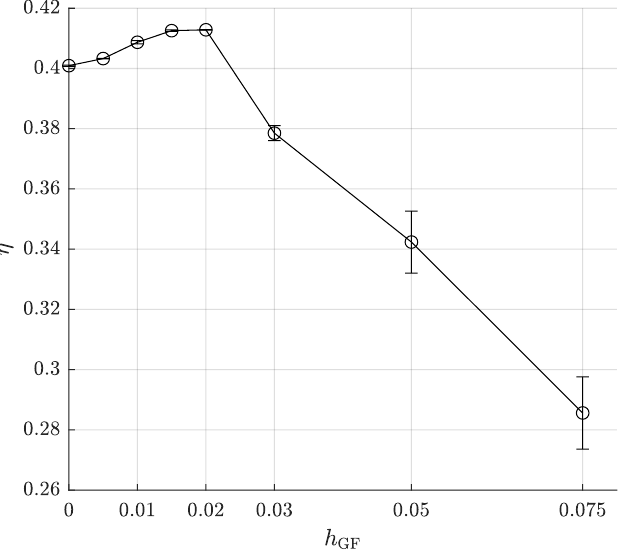
Figure 6. Effect of Gurney flaps on the performance of an OFT operating at f ∗ = 0.18, H 0 = c , α 0 = 29 ◦ , φ = 90 ◦ fitted with various heights of double Gurney flaps (error bars showing variation of η over last 5